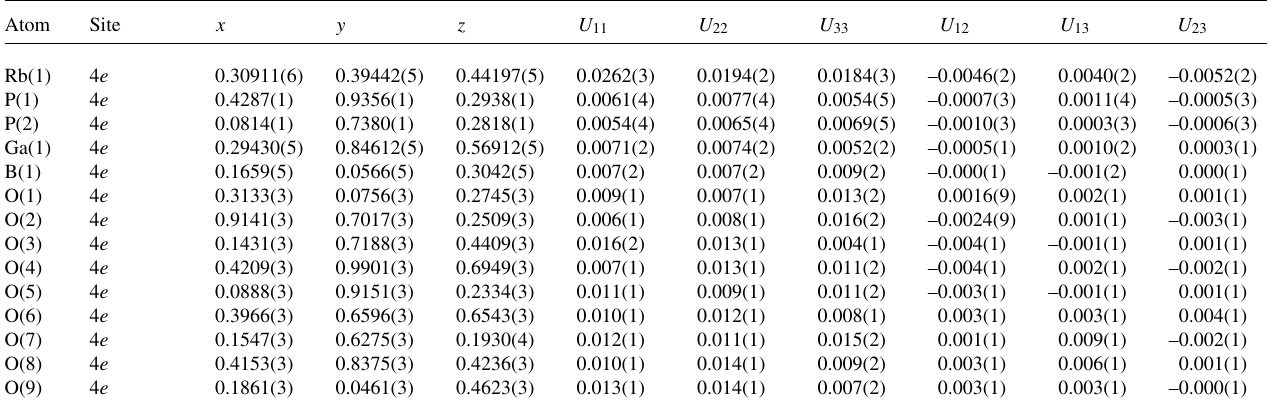
Table 3. Atomic coordinates and displacement parameters (in Å 2 ) .